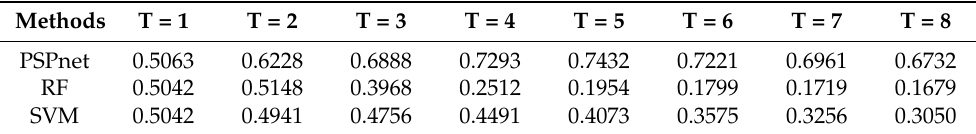
Table A9. The IoU of sample size S = 75 varies with the threshold level T.